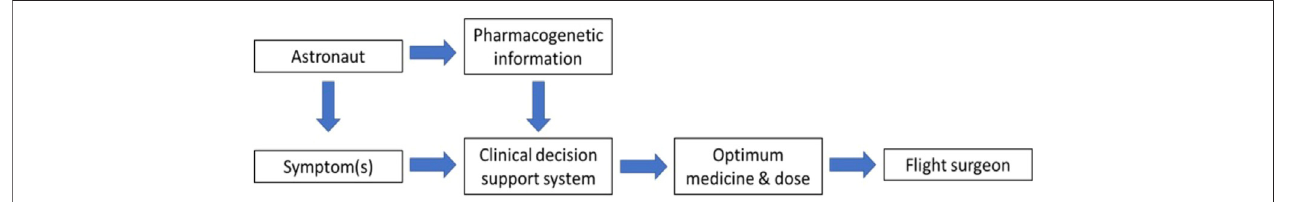
FIGURE 5 | Incorporating astronaut pharmacogenetic information into clinical decision support to help the fl ight surgeon.